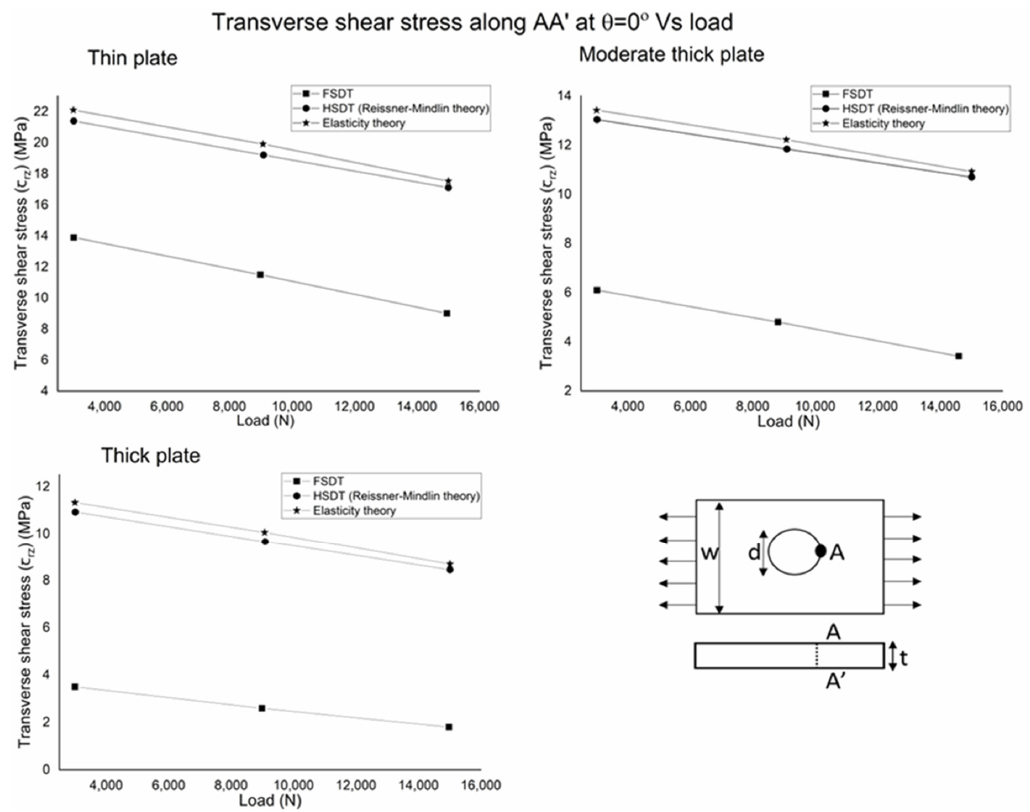
Table 2. Transverse shear stress and SCF for a braided polymer material.